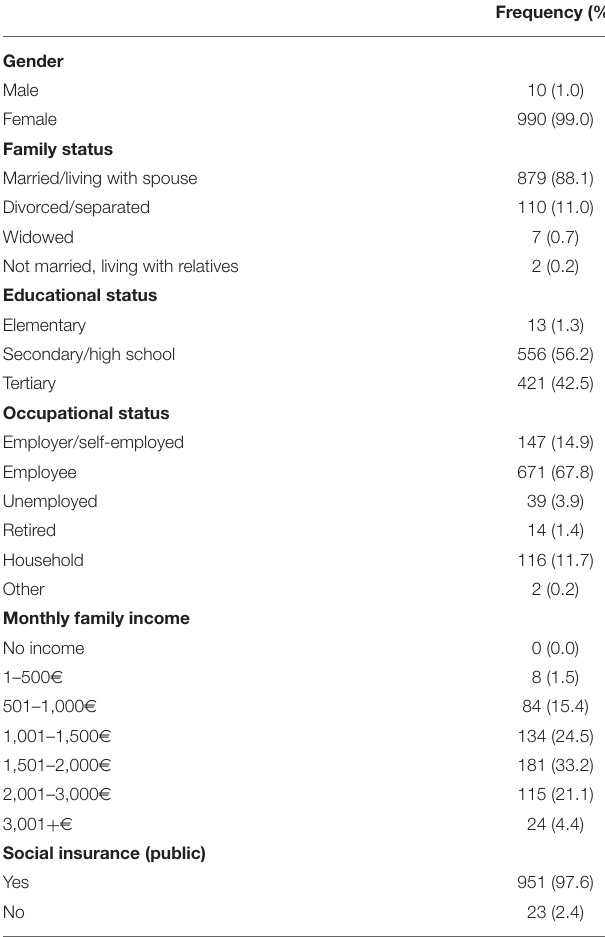
TABLE 1 | Sociodemographic characteristics of the study